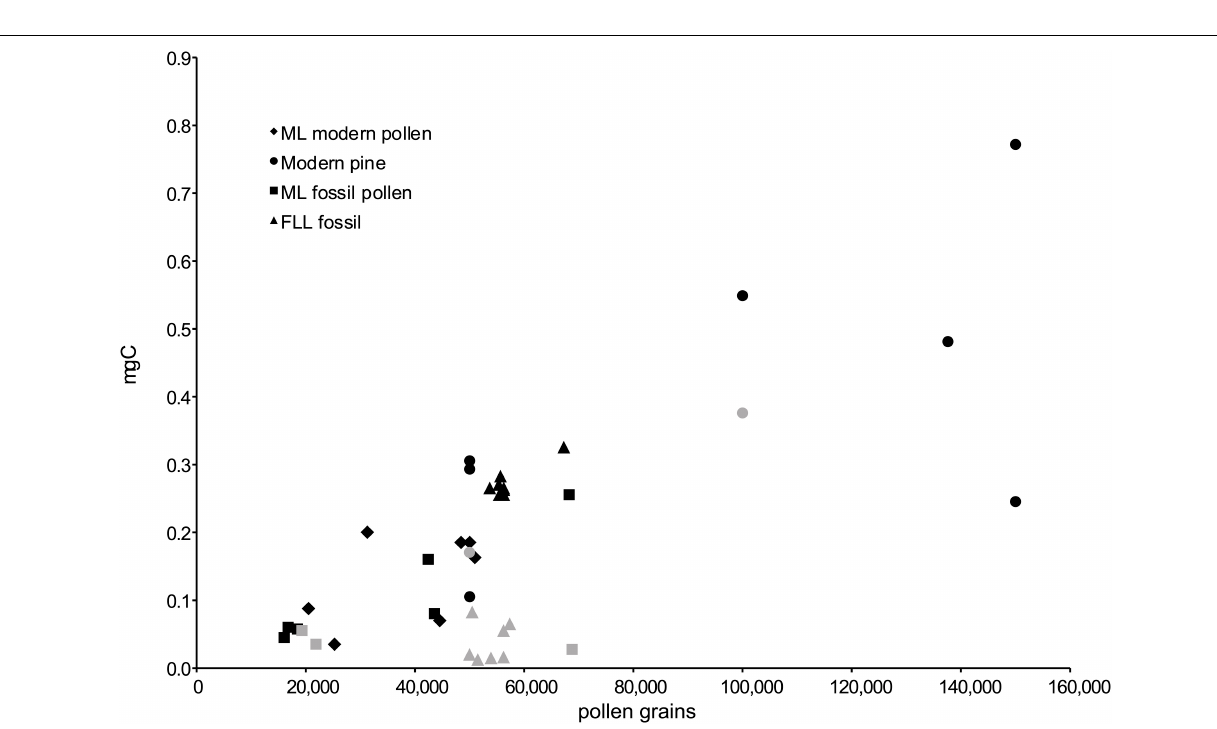
Frontiers in Ecology and Evolution |